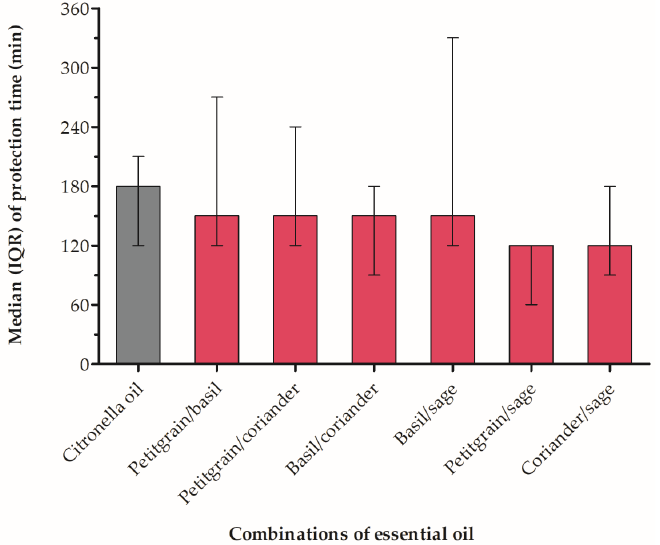
Figure 2. Median with interquartile range (IQR) protection times of essential oil combinations and citronella oil (control) against Aedes aegypti .